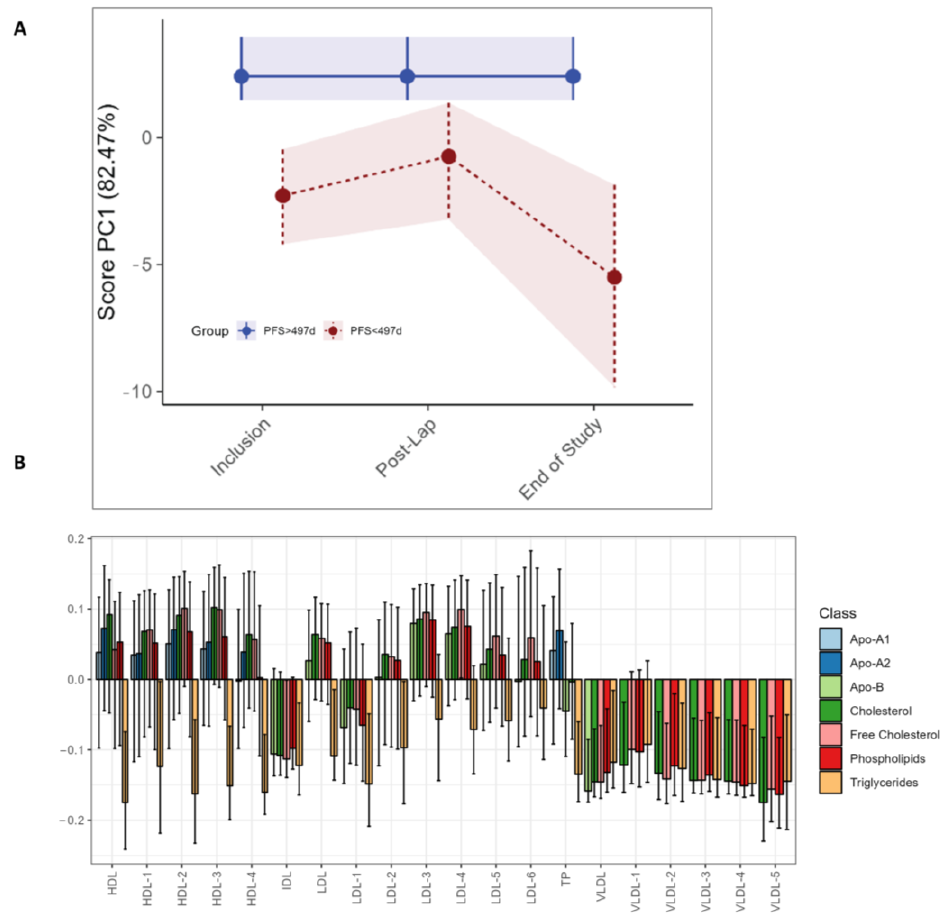
Figure 5. RM–ASCA+ scores plot of the time:group effect for PFS subgroups, demonstrating changes in lipoproteins over time. Only the three visits are included due to an uneven distribution of short vs. long PFS patients. The pre- and post-operative and pre-chemotherapy visits (Arm I only) had too few patients with short PFS to make a comparison. ( A ) The trajectory of lipoprotein subfractions (scores) on principal component 1 is shown for the short PFS group (red) relative to the long PFS (blue) group. The time development of the long PFS group has been removed to highlight the effect of short PFS. ( B ) The loading plot of lipoproteins shows the trajectory lines in ( A ), where the variation reflects differences in the short PFS group relative to the long PFS group. The scores show the overall development of lipoprotein subfractions over time. Bars are color coded according to the major subclasses of lipoproteins (Table S2). The 95% confidence interval is marked with black lines within the bars.